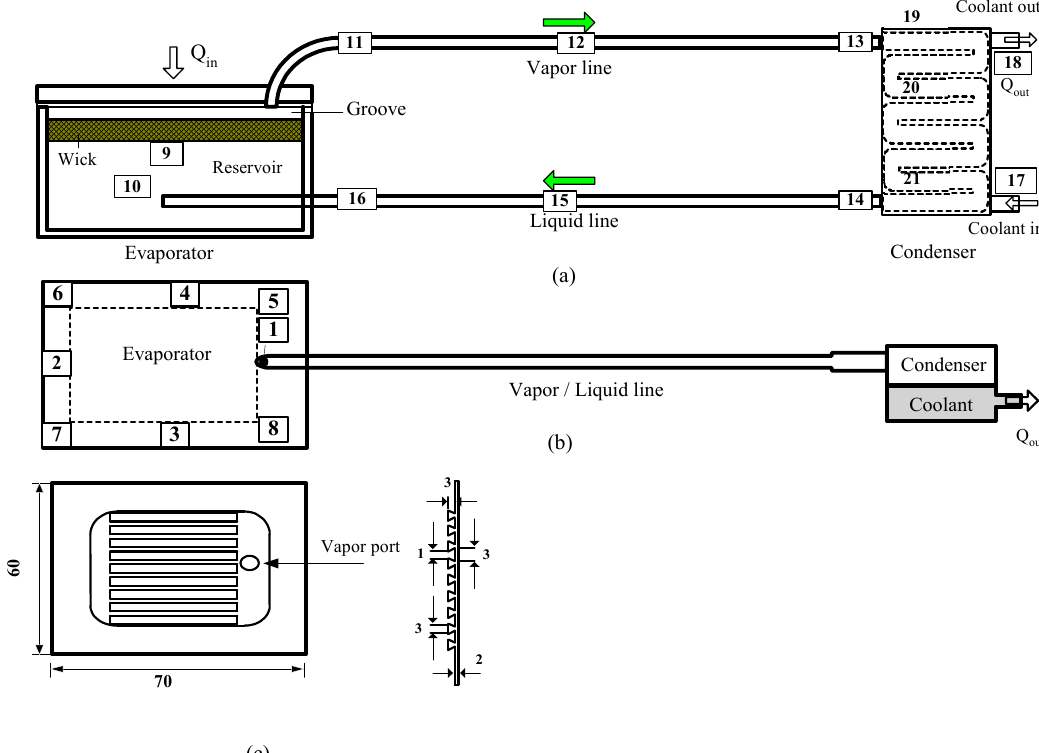
Figure 1. Schematic of the loop heat pipe (LHP) fabricated in this study and location of thermocouples: ( a ) Side view; ( b ) Plane view; ( c ) Vapor removal groove (units: mm); Thermocouple locations: 1–8: evaporator wall ( T ew ), 9: wick inlet ( T wick.i ), 10: liquid reservoir ( T r ), 11: evaporator outlet ( T ev ), 12: vapor line ( T vl ), 13: condenser inlet ( T ci ), 14: condenser outlet ( T co ), 15: liquid line ( T ll ), 16: evaporator inlet ( T ei ), 17: coolant inlet ( T cool. in ), 18: coolant outlet ( T cool.out ), 19–21: condenser wall ( T cw ).